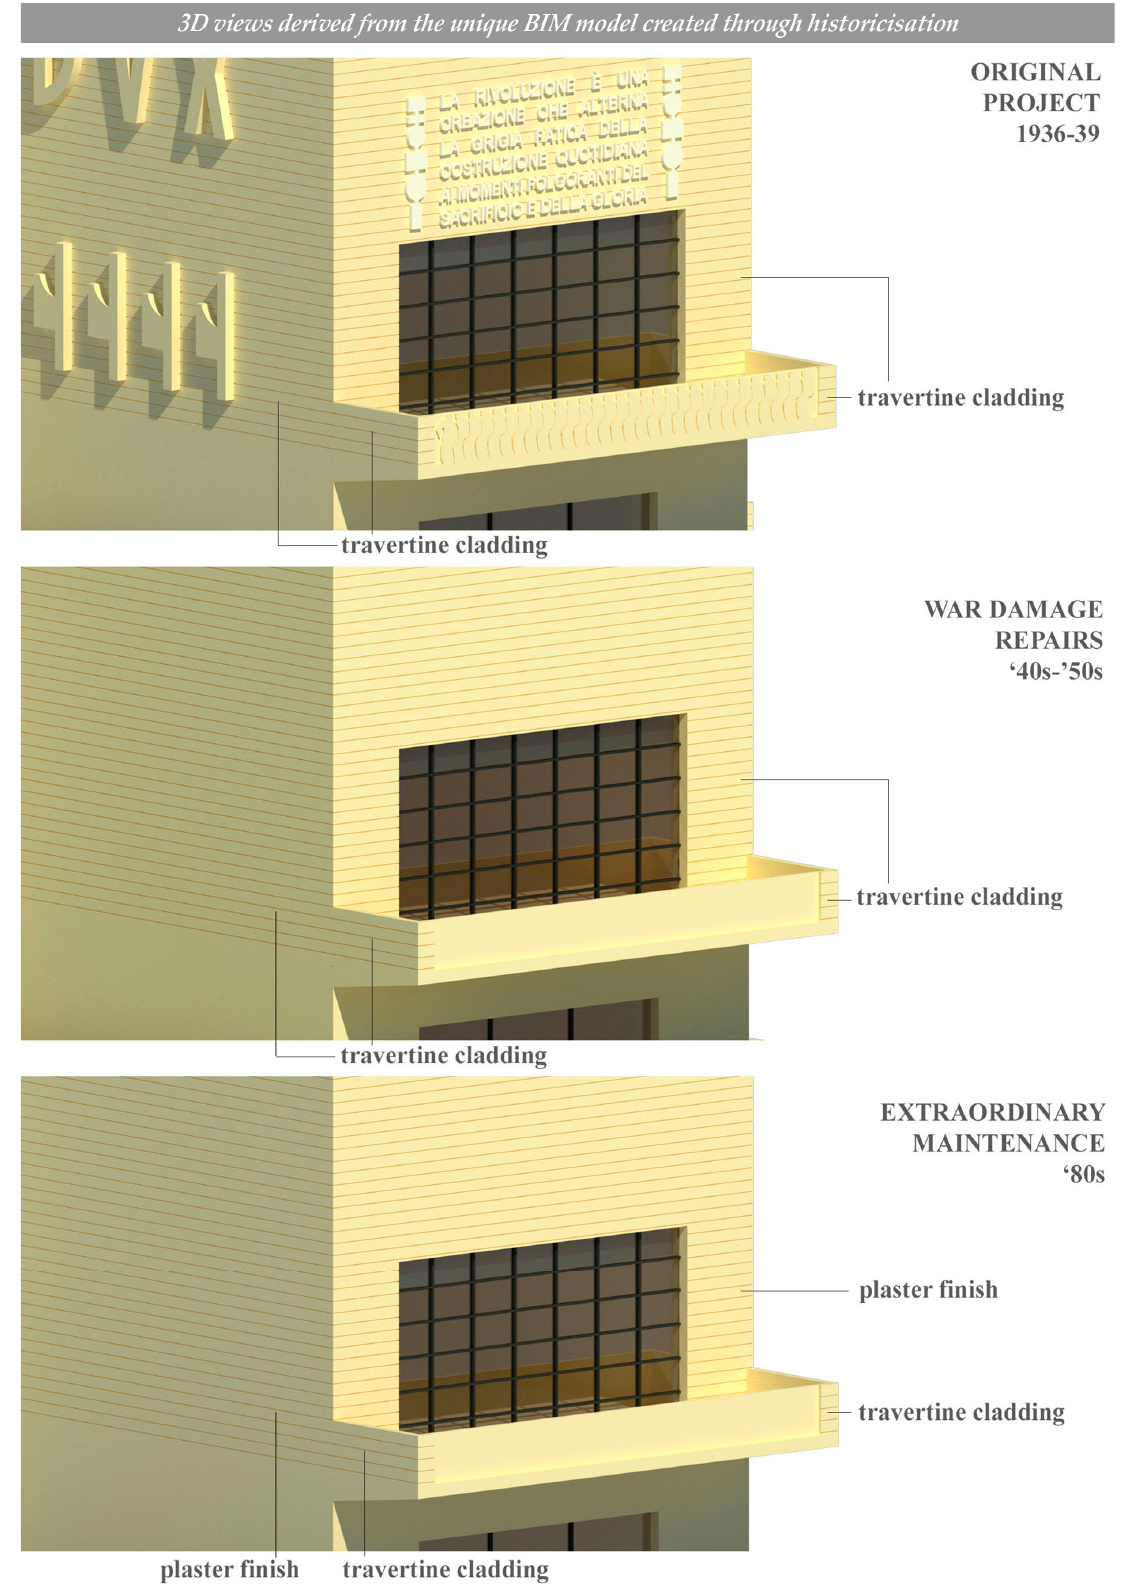
Figure 15. The model historicisation to document the variation of firmitas of the former Fascist House. The changes to finish materials of the tower façades.